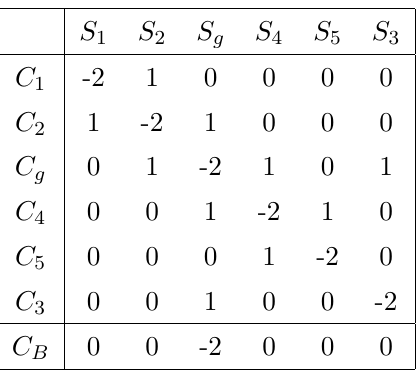
; 5 ; g and the (cid:1) (cid:1) (cid:1)